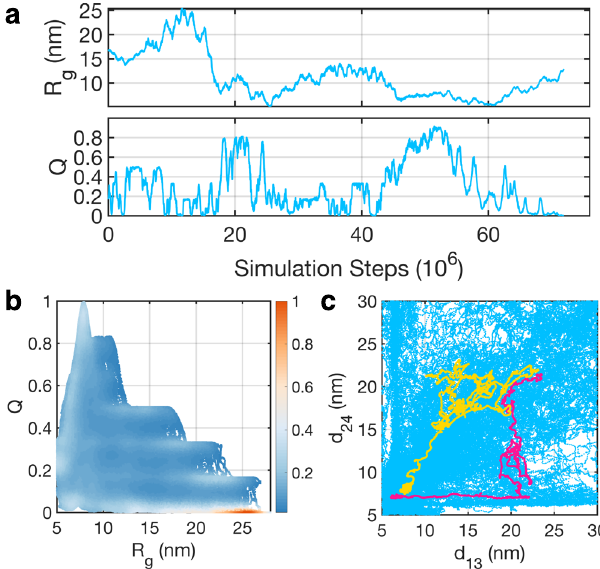
Fig. 1 Direct simulations of the tetra-nucleosome folding process enabled via an advanced sampling technique. a Time evolution of the two collective variables along an example trajectory during which chromatin undergoes multiple folding and unfolding transitions. b Scatter plot of all the sampled tetra-nucleosome con fi gurations represented by R g and Q . Color scale represents relative frequency estimated from direct counting that increases from blue to white and to red. c Scatter plot of all the tetra- nucleosome con fi gurations represented by 1 – 3 and 2 – 4 nucleosome distances. Two example trajectories that correspond to the concerted and sequential folding pathway are highlighted in yellow and pink,